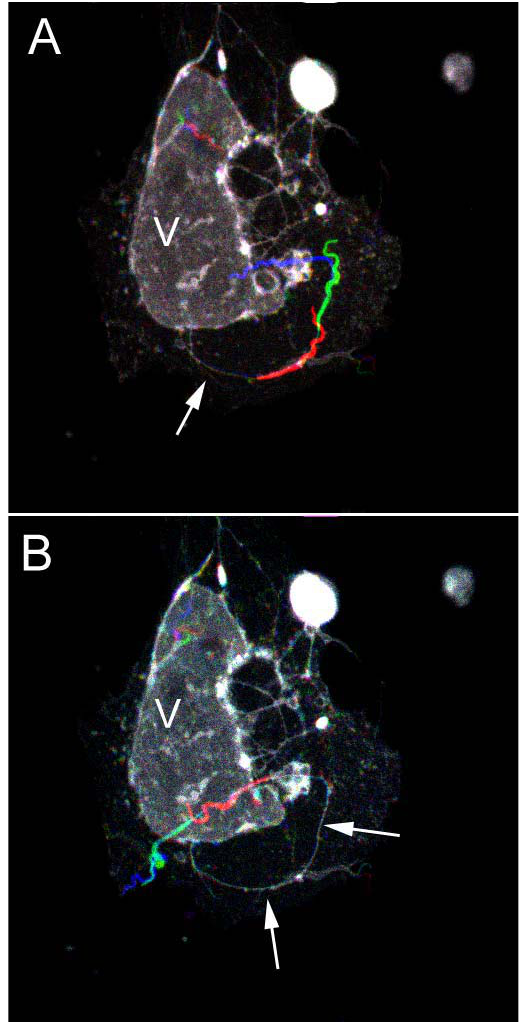
Fig. 6– T.cruzi metacyclicPVsmoveinsideVerocellsharboring C.burnetti leavingtrailsofLAMP-1. Verocellscolonizedwith C. burnetii were transfected with eGFP-LAMP1 then infected with metacyclic trypomastigotes (CL strain). A, B: sequential RGB merged images (10 seconds interval between images), showing moving parasites (in colors) with the LAMP-1 trail (arrows) and large vacuole (V) labeled with eGFP-LAMP-1 that remain still (thus in gray tones) in the timeframe of the